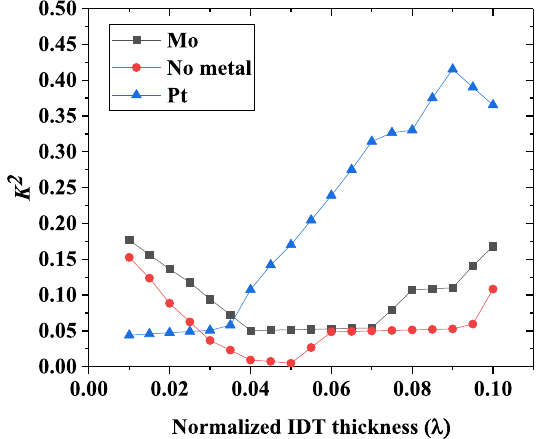
Figure 6. K 2 for the different metal layer materials as a function of normalized IDT thickness.